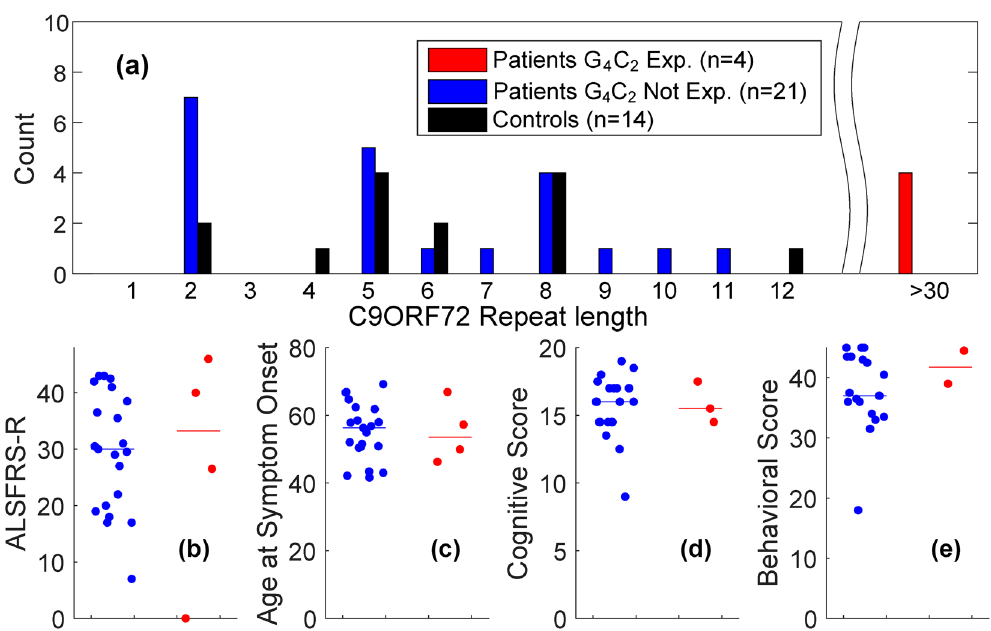
Figure 1. ( a ) Histogram of C9ORF72 allele lengths. The presence of a repeat expansion among ALS patients (horizontal line indicates group median) does not significantly associate with ( b ) ALSFRS-R score, ( c ) age at symptom onset, ( d ) cognitive impairment, or ( e ) behavioral